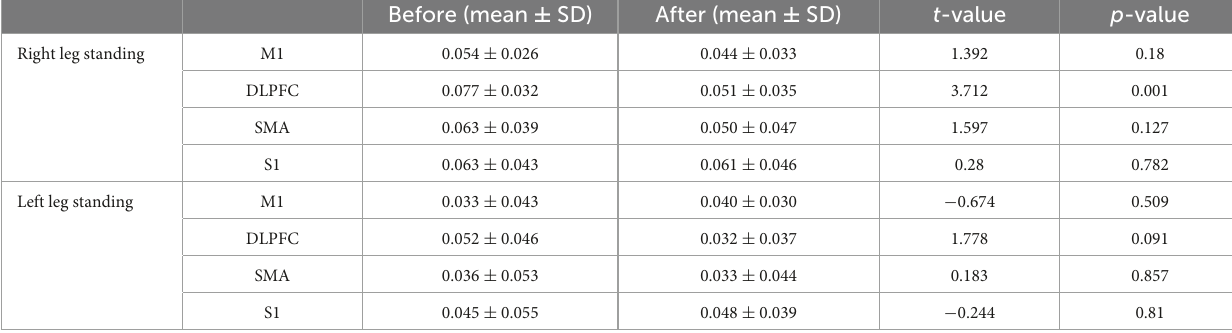
TABLE 1 HbO changes (mmol/L) of four ROIs during single-leg standing tasks before and after iTBS over the